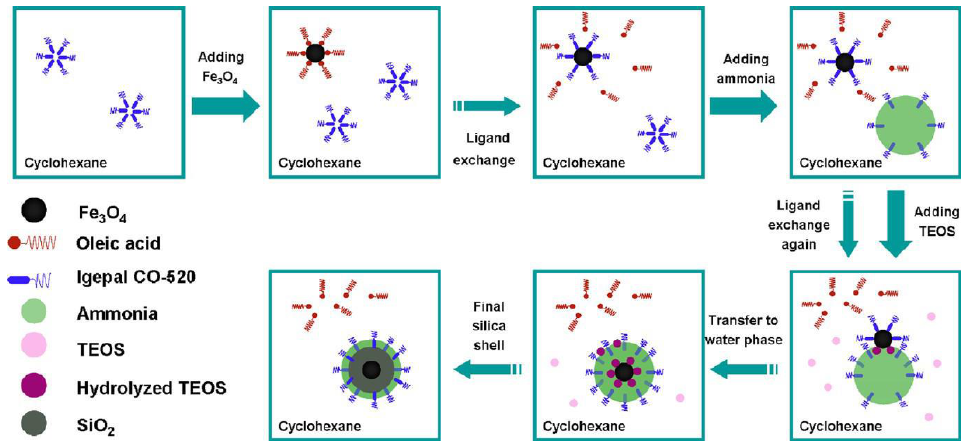
Figure 3. Illustration of the coating mechanism of SiO 2 on the Surface of Fe 3 O 4 NPs. Reproduced with